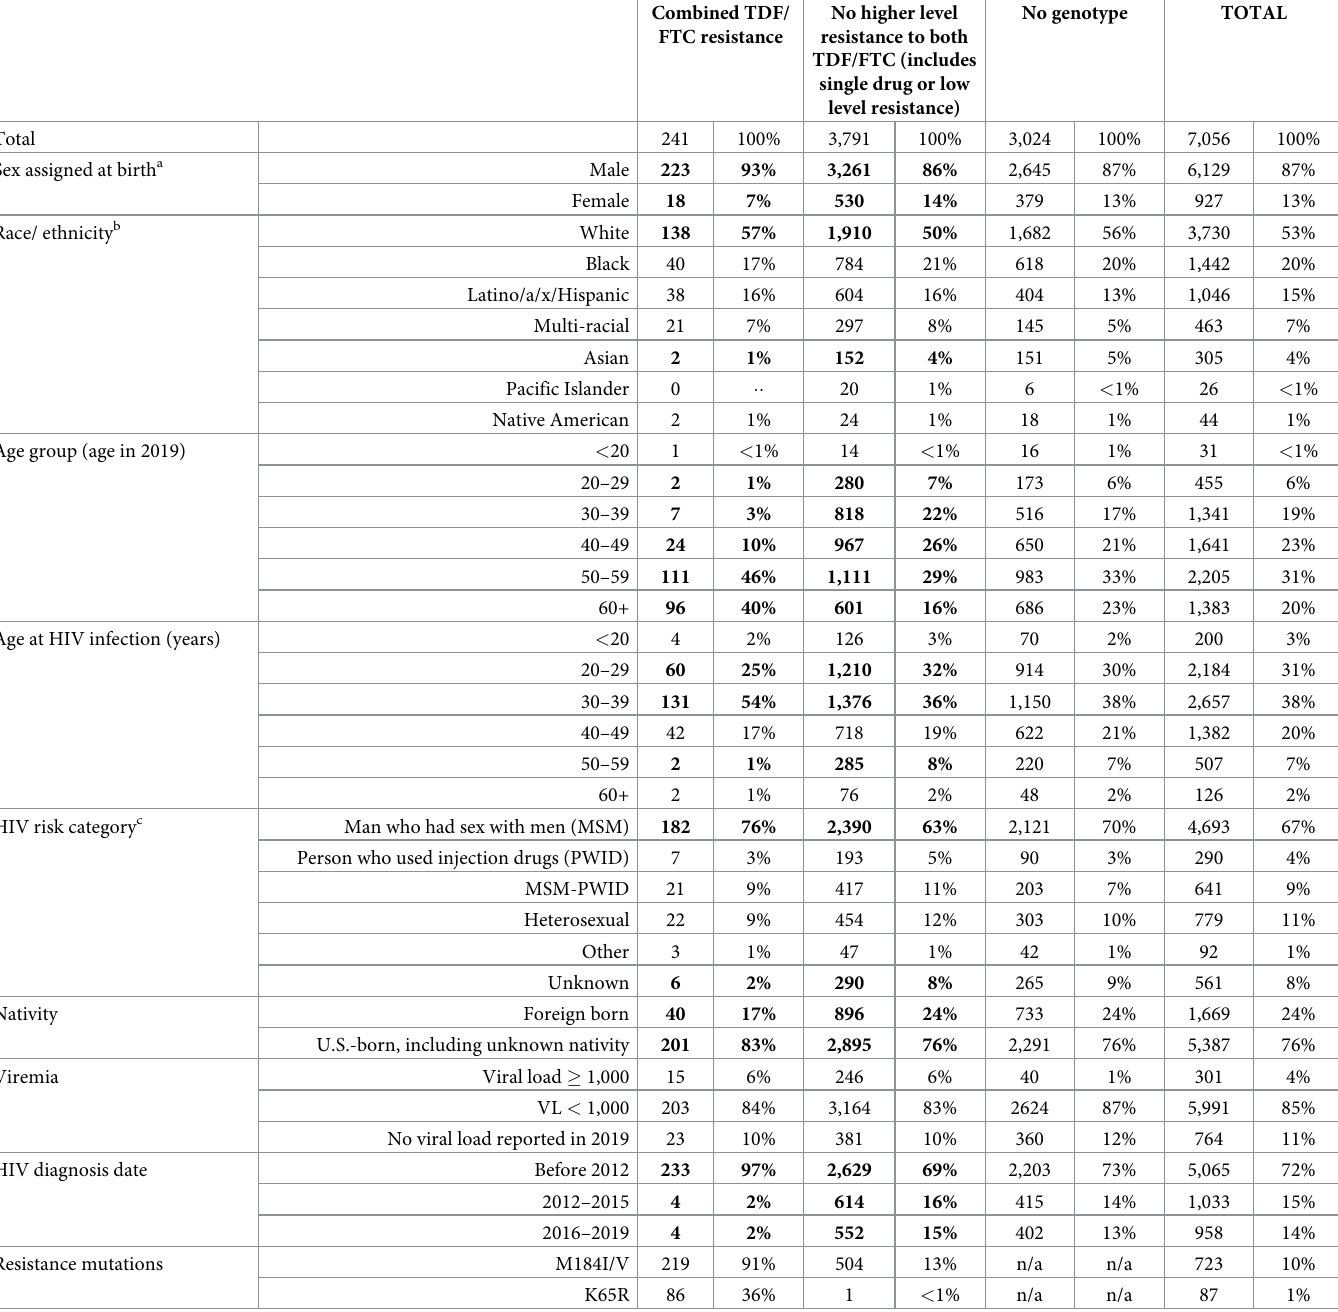
Table 1. People living with HIV in King County, WA at the end of 2019 by genotypic test results indicating tenofovir/emtricitabine (TDF/FTC) resistance.